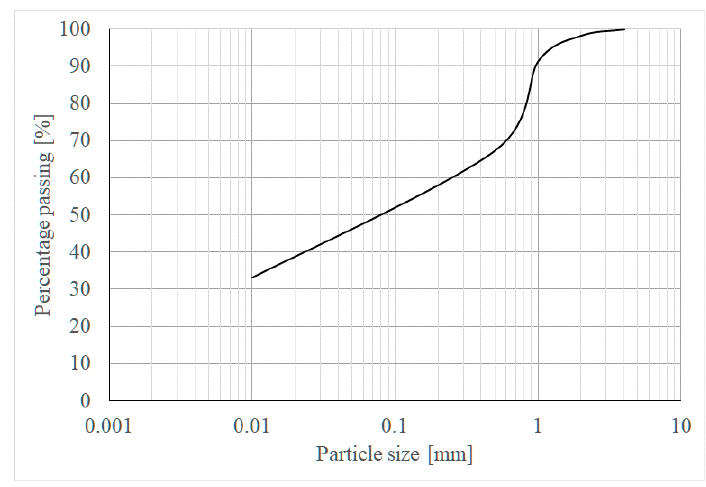
Figure 3. Particle size distribution of the snow particles used in this experiment.